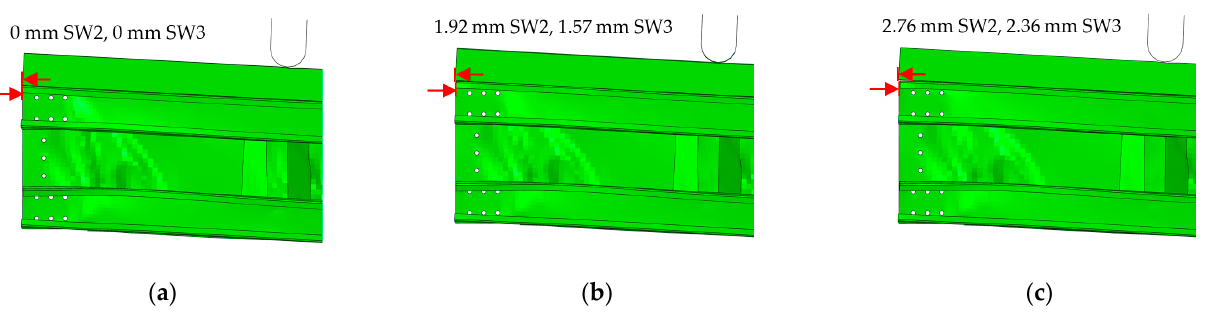
Figure 20. Differences in end slip between three analysed solutions of fixed beam: ( a ) full tie shear connection; ( b ) shear connectors spaced at 300 mm; ( c ) shear connectors spaced at 600 mm.